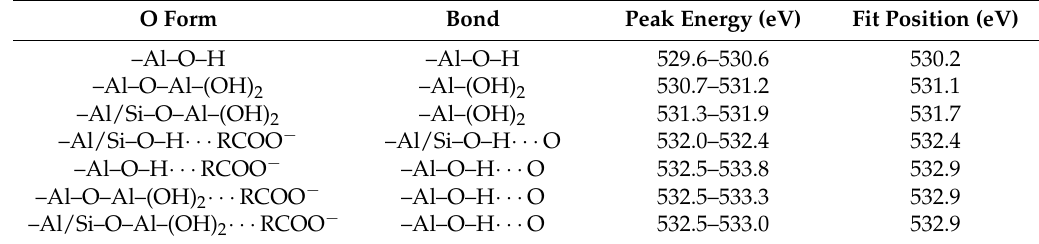
Table 4. O 1s NEXAFS approximate energy ranges and primary absorption peaks (“ · · · ” means Hydrogen